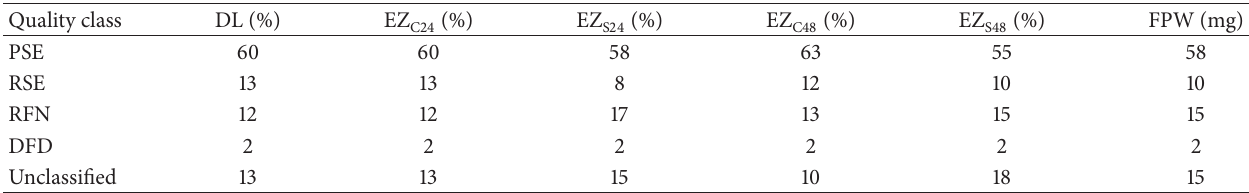
Table 4: Frequency (%) of occurrence of each quality class by Warner et al. [12] criteria following characterization by the WHC method measured on pork loin ( Longissimus thoracis muscle; n = 60) samples.